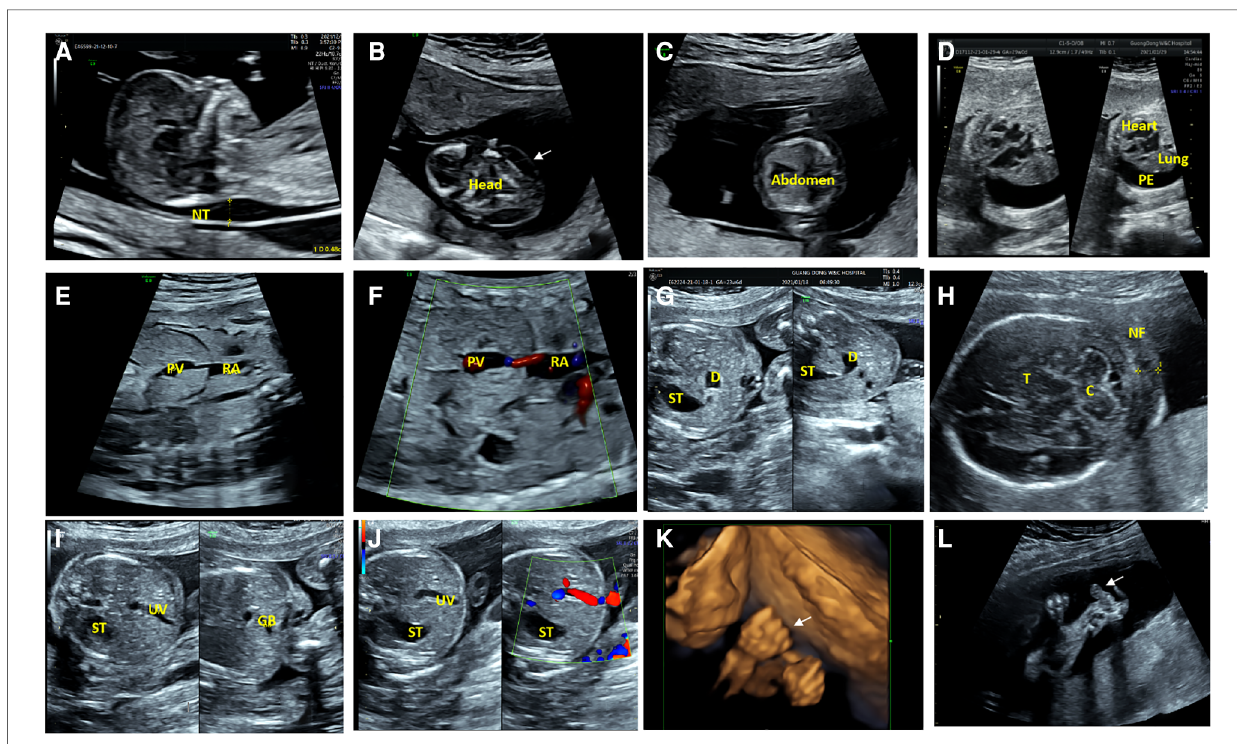
FIGURE 2 Less common ultrasound features in our study. ( A ) The ultrasonic examination of case 8 showed a thickened nuchal translucency (NT) in the midsagittal view. ( B,C ) The transverse view of the fetal brain and abdomen of case 8 showed hydroderma (the white arrow). ( D ) The ultrasound examination of case 10 showed a left pleural effusion (PE), and dextroposition of heart in the four-chamber view. ( E,F ) Two-dimensional and color Doppler ultrasonic images of case 9 showed the absence of venous duct and abnormal connection between the portal vein (PV) sinus and the right atrium (RA) in the oblique coronal view. ( G )The transverse view of the upper abdomen of the fetus 11 presented a typical double bubble sign. The anechoic region on the left side of the abdomen is the stomach (ST) and the anechoic region on the right is the expanded duodenum ( D ). ( H ) The ultrasonic examination of the case 12 showed a thickened nuchal fold (NF) in the transverse view of cerebellar. C, Cerebellum; T, Thalamus. ( I,J ) Two-dimensional and color Doppler ultrasonic images of the fetus 11 showed that the umbilical vein(UV) runs towards to the stomach(ST), and the gallbladder(GB) is located to the left of the umbilical vein in the transverse view of the abdomen. ( K ) Three-dimensional ultrasonic images of the fi ngers showed the hands of case 12 presented in a continuous “ Thumb- in-Fist Posture ” . ( L ) The ultrasonic examination of case 12 showed that thumbs were continuously adducted, and hypoechoic mass presented in the left radial